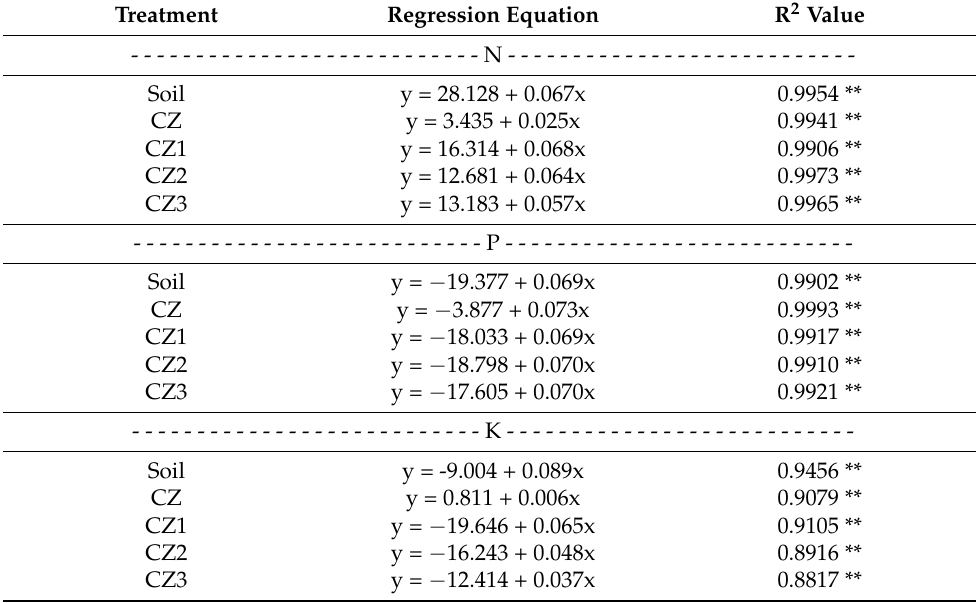
Table 7. Linear relationships between the added amounts nitrogen, phosphorus, and potassium and their contents in the equilibrated